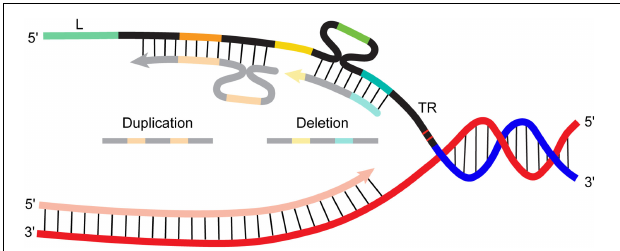
FIGURE 2 | Cartoon diagram of spacer-repeat duplication and deletion events created by misalignment of the nascent strand during replication. L, leader; TR, terminal repeat, all other repeats depicted in black, spacers depicted in color ( orange , yellow , green , aqua